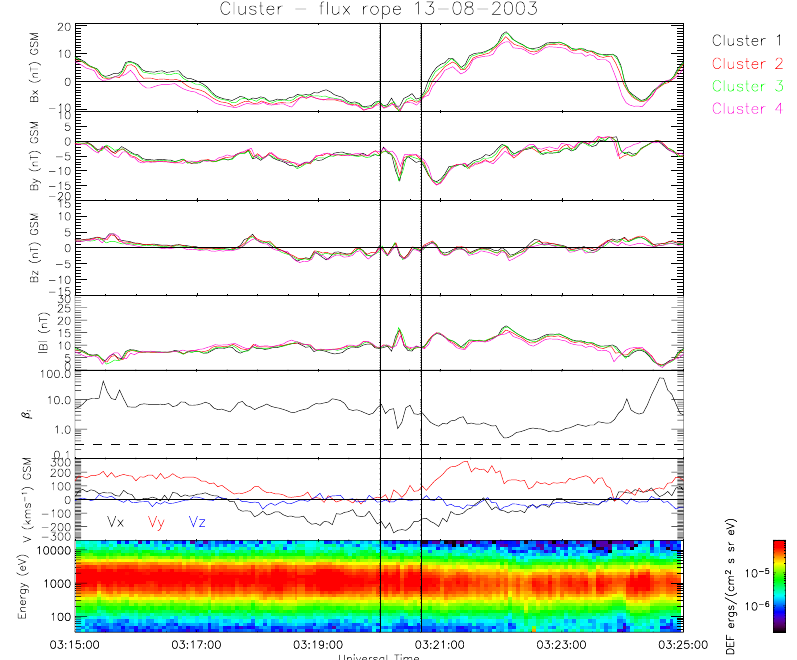
Fig. 10. Cluster observations of 13 August 2003 in the same format as Fig. 3.